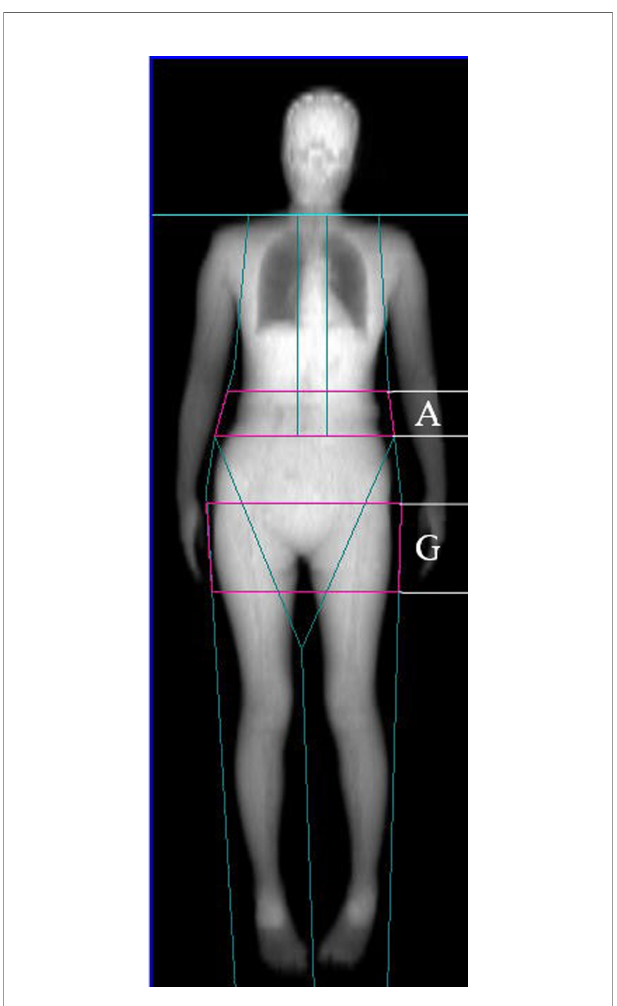
FIGURE 1 | Dual-energy X-ray absorptiometry-based body composition measurement (A: android fat distribution ROI, G: gynoid fat distribution